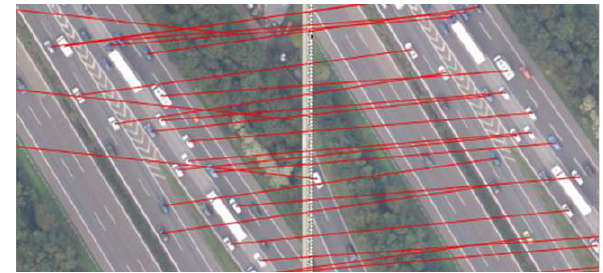
Figure 6: Tracking of cars using shape-based